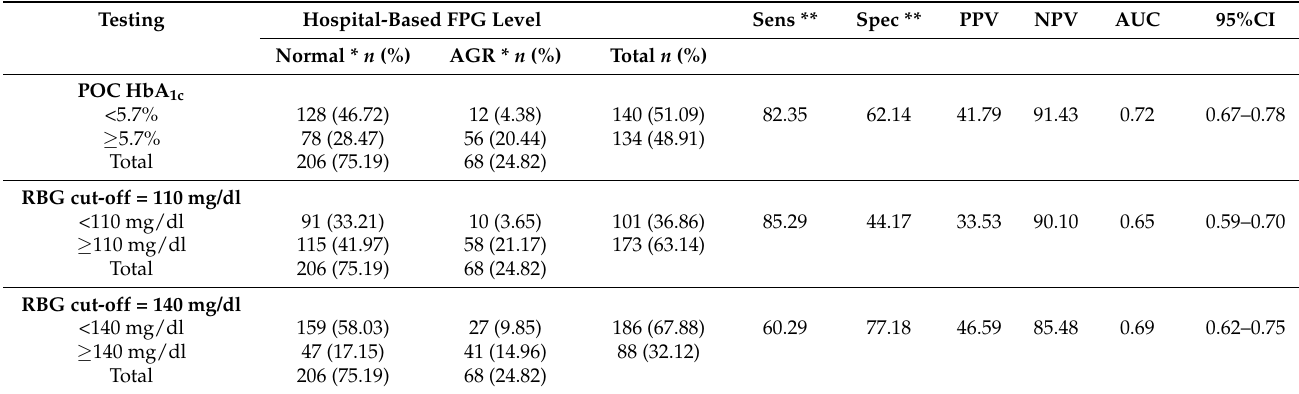
Table 3. Sensitivity, specificity, PPV, and NPV of POC testing compared to hospital-based laboratory testing using FPG levels. ( n = 274).